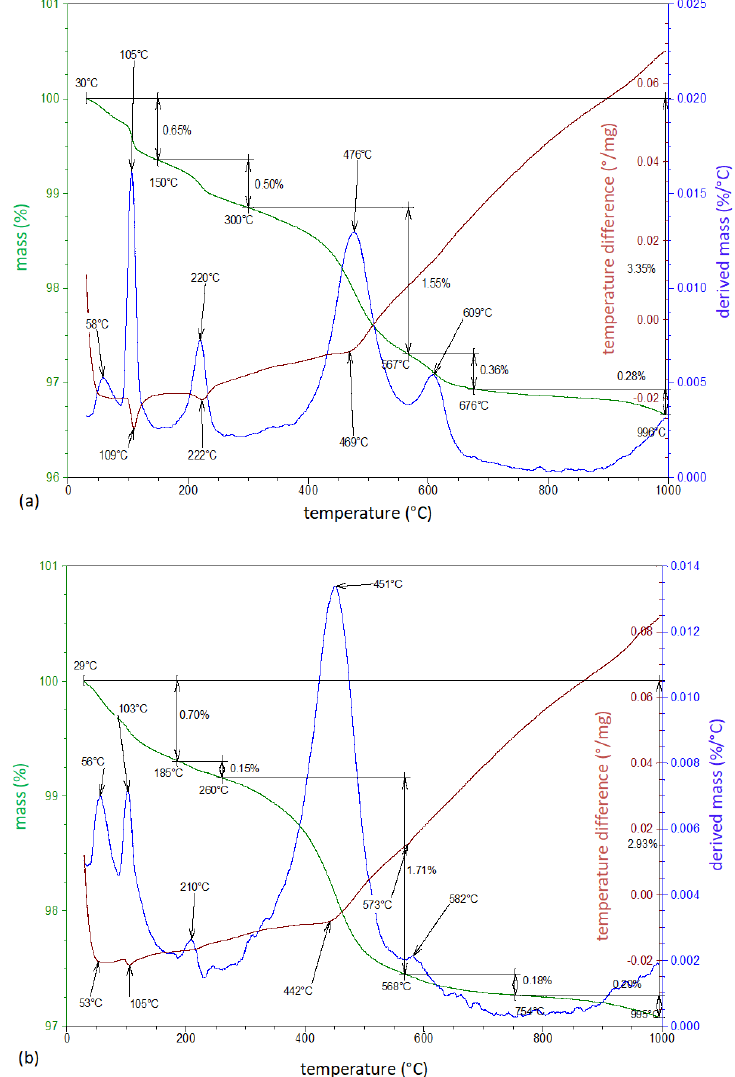
Figure 5. Thermogram sample of the ceramic dust with a fraction of 0/1 mm ( a ) and 0/2 mm ( b ).